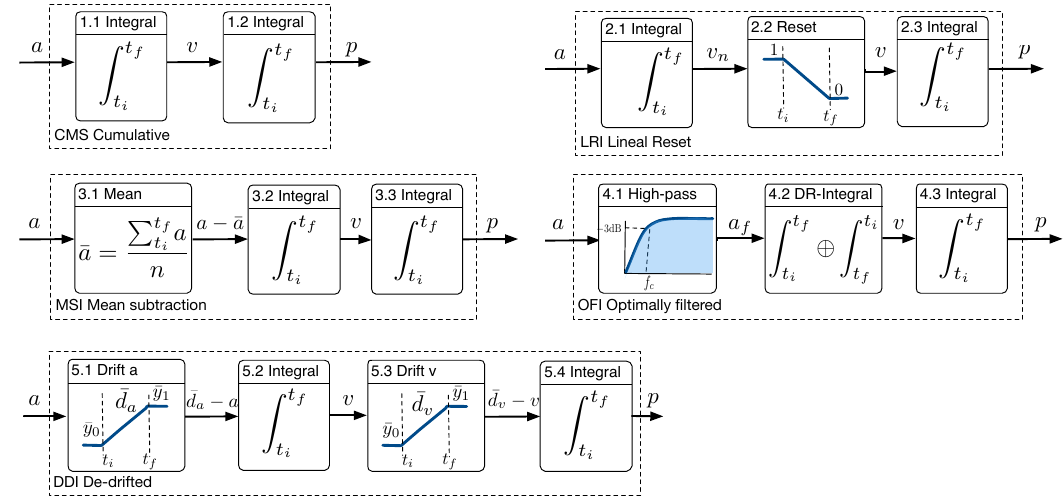
Figure 1. Estimation methods compared in this